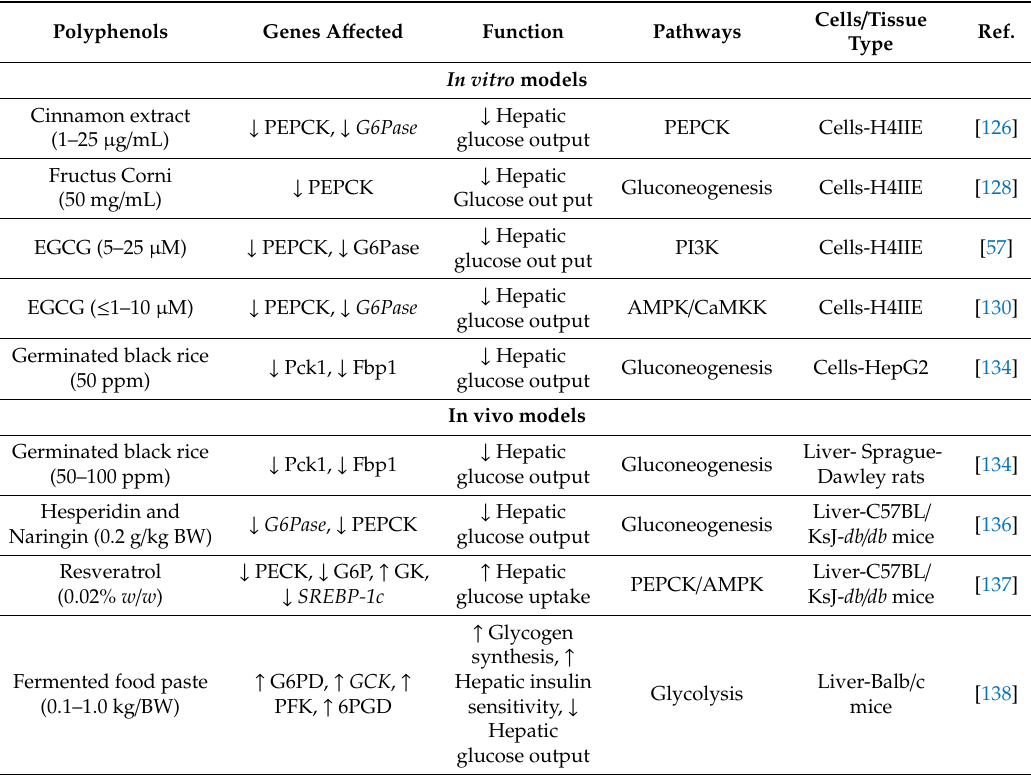
Table 4. Polyphenols and gene modulations on gluconeogenesis